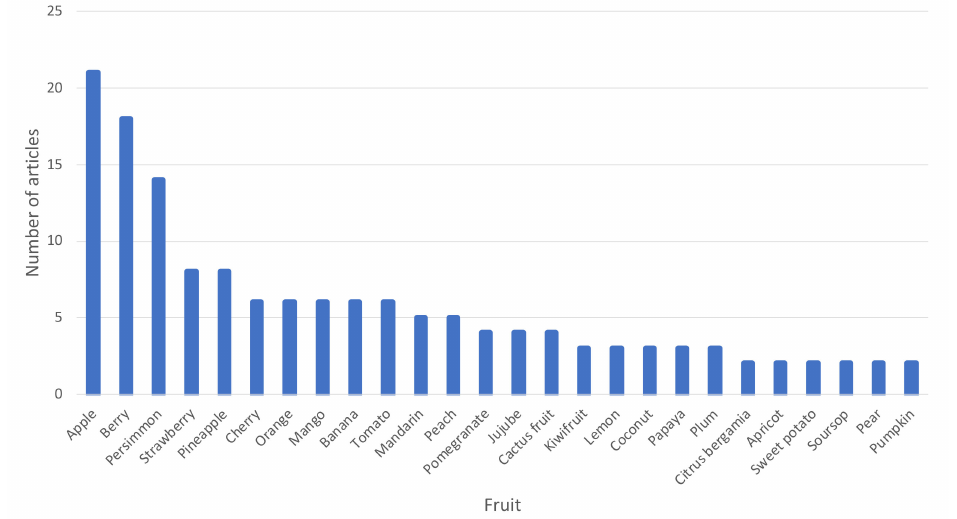
Figure 3. Different fruits (other than grapes) employed for the elaboration of fruit vinegars for which two or more scientific articles about the technological process have been found in the literature from 1990 to